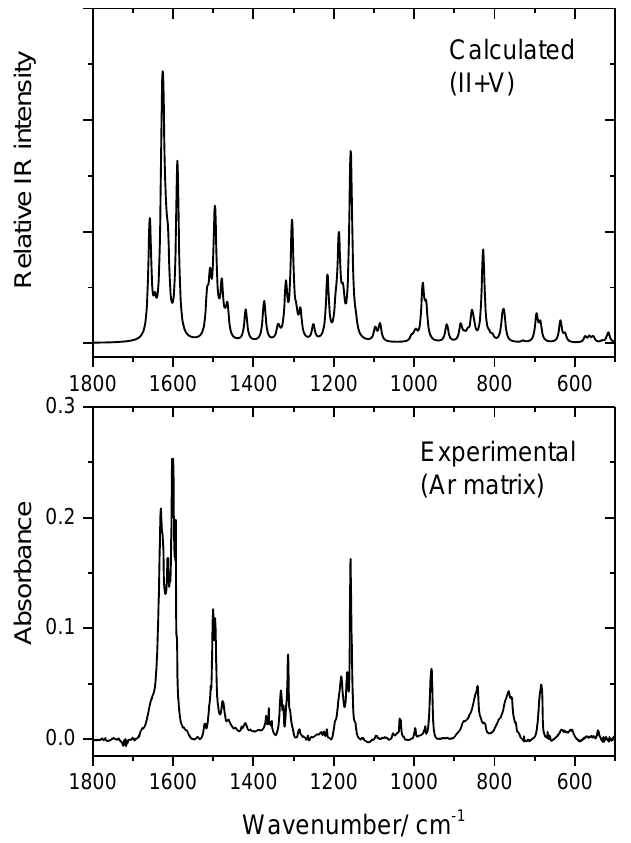
Figure 6. Infrared spectrum of BHAP in an Ar matrix (10 K) in the 1800–500 cm − 1 range ( bottom ), and sum spectrum of the B3LYP/6-311++G(d,p) calculated spectra for E -enol-imine conformers II and V.